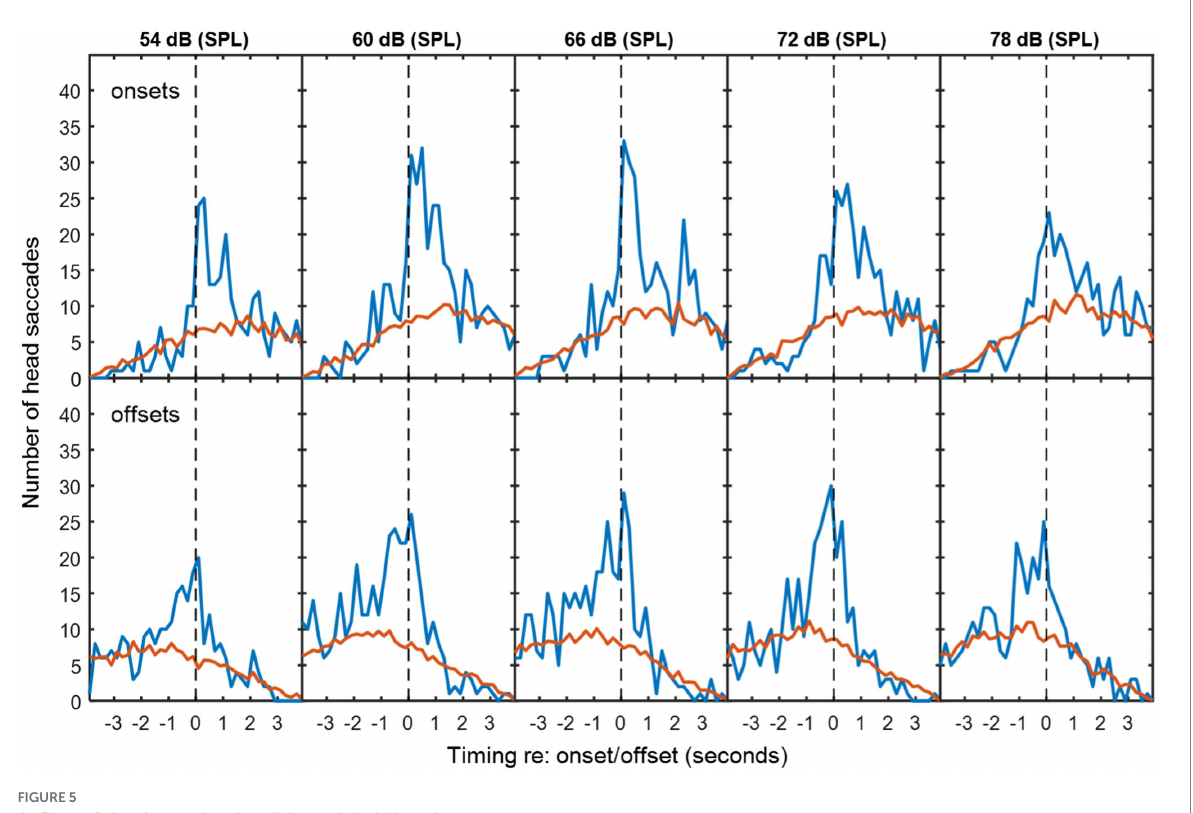
FIGURE 5 As Figure 2, but for overlapping dialogue in babble